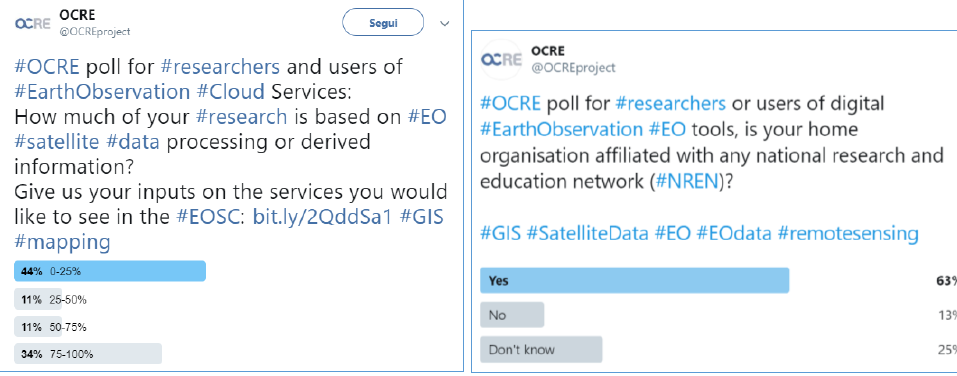
Figure 7. Twitters raising the awareness of the OCRE